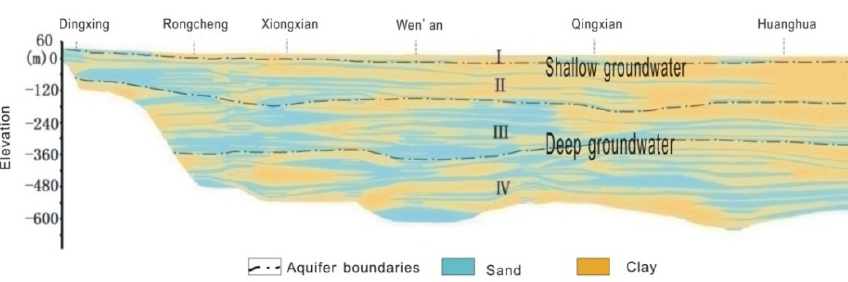
Figure 2. Hydrogeological section of the study area [29].